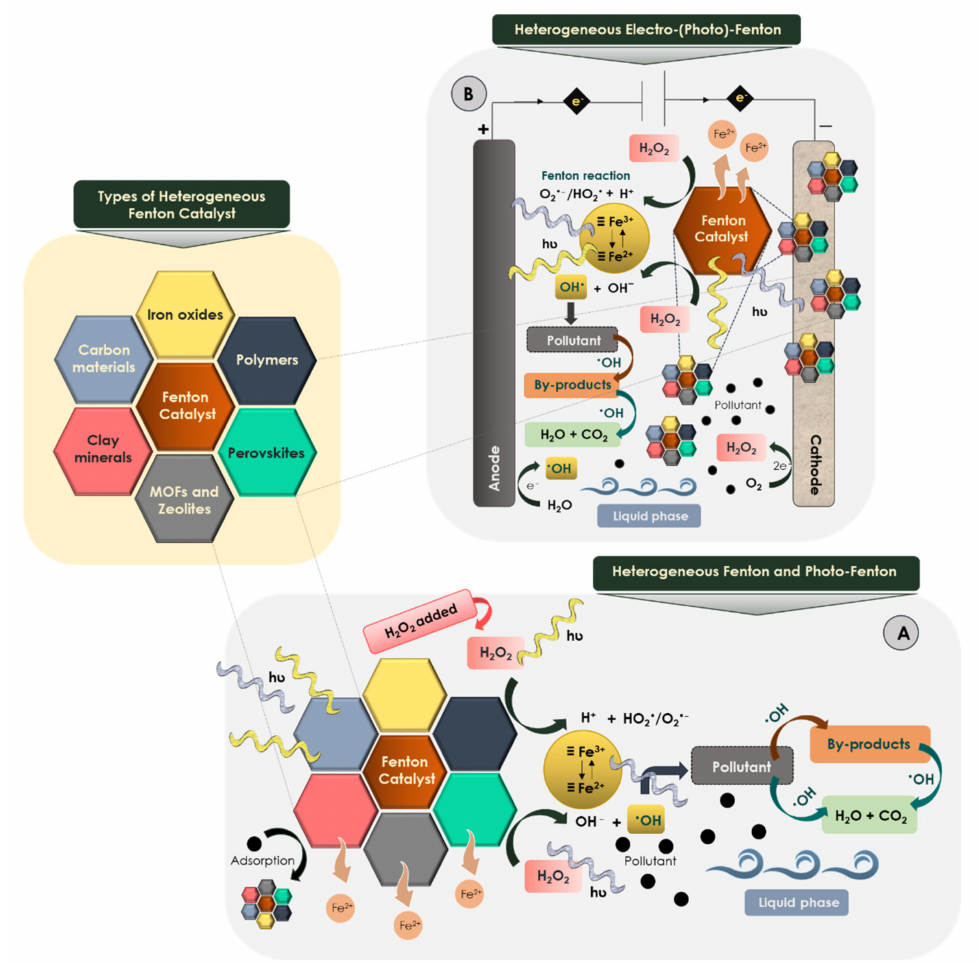
Figure 3. Mechanisms of heterogeneous Fenton processes. ( A ) Heterogeneous Fenton and photo- Fenton processes. ( B ) Heterogeneous electro-Fenton and electro-photo-Fenton